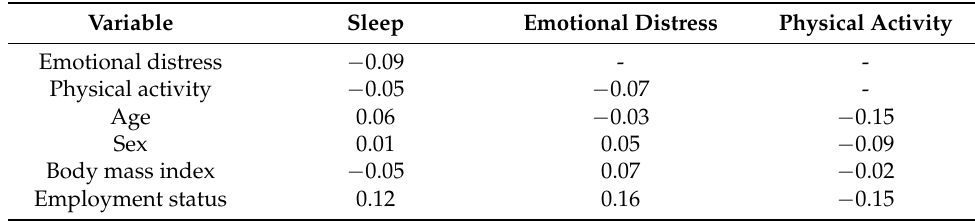
Table 4. Correlations between the relevant variables of interest and covariates for the stratified Black population ( n =